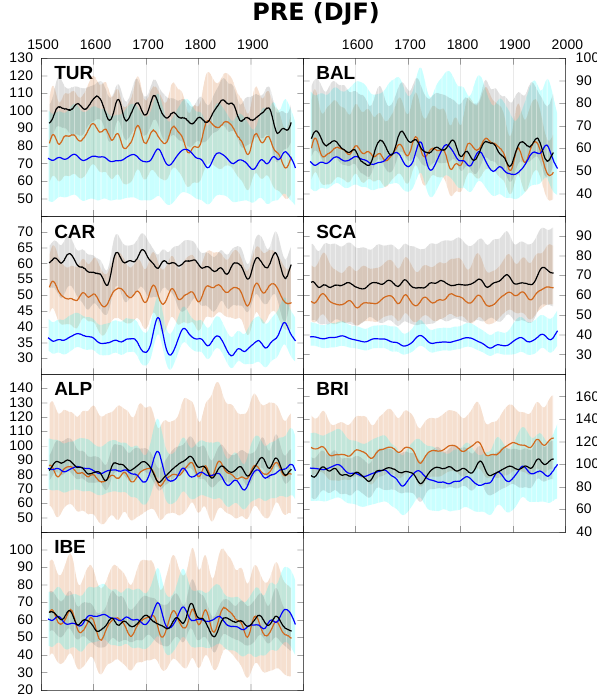
Figure 4. As Fig. 2 but for winter PRE. PRE reconstructions by Pauling et al.